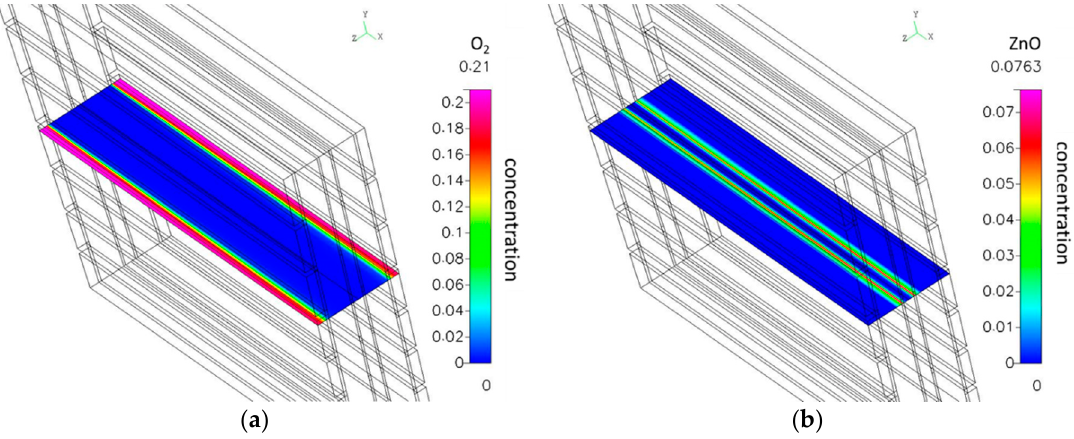
Figure 5. Mass fraction contours of ( a ) O 2 and ( b ) ZnO in the mid ‐ cross ‐ sectional ( x ‐ z ) plane.